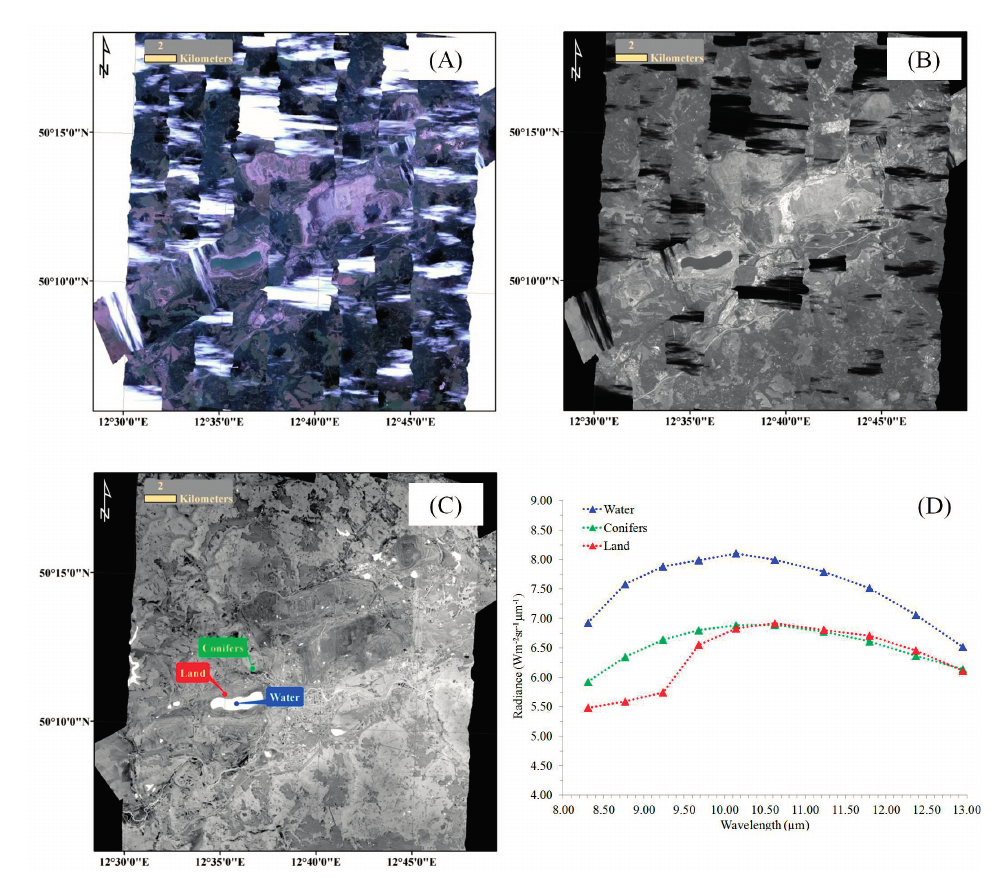
Figure 2. ( A ) RGB image (R = 0.650 µm, G = 0.560 µm, B = 0.471 µm) and ( B ) daytime LWIR image (band 10.14 µm) of the Sokolov lignite mining area acquired with the AHS sensor; ( C ) Nighttime LWIR image (band 10.14 µm) with three regions of interest (ROIs) and ( D ) nighttime LWIR at-sensor radiance of the three